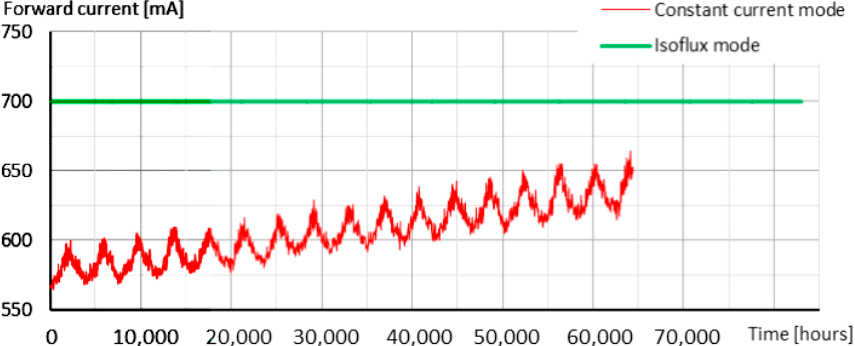
Figure 9. The forward currents applied during the simulation (the absolute maximum DC forward current of the Luxeon Z LEDs is 1 A).